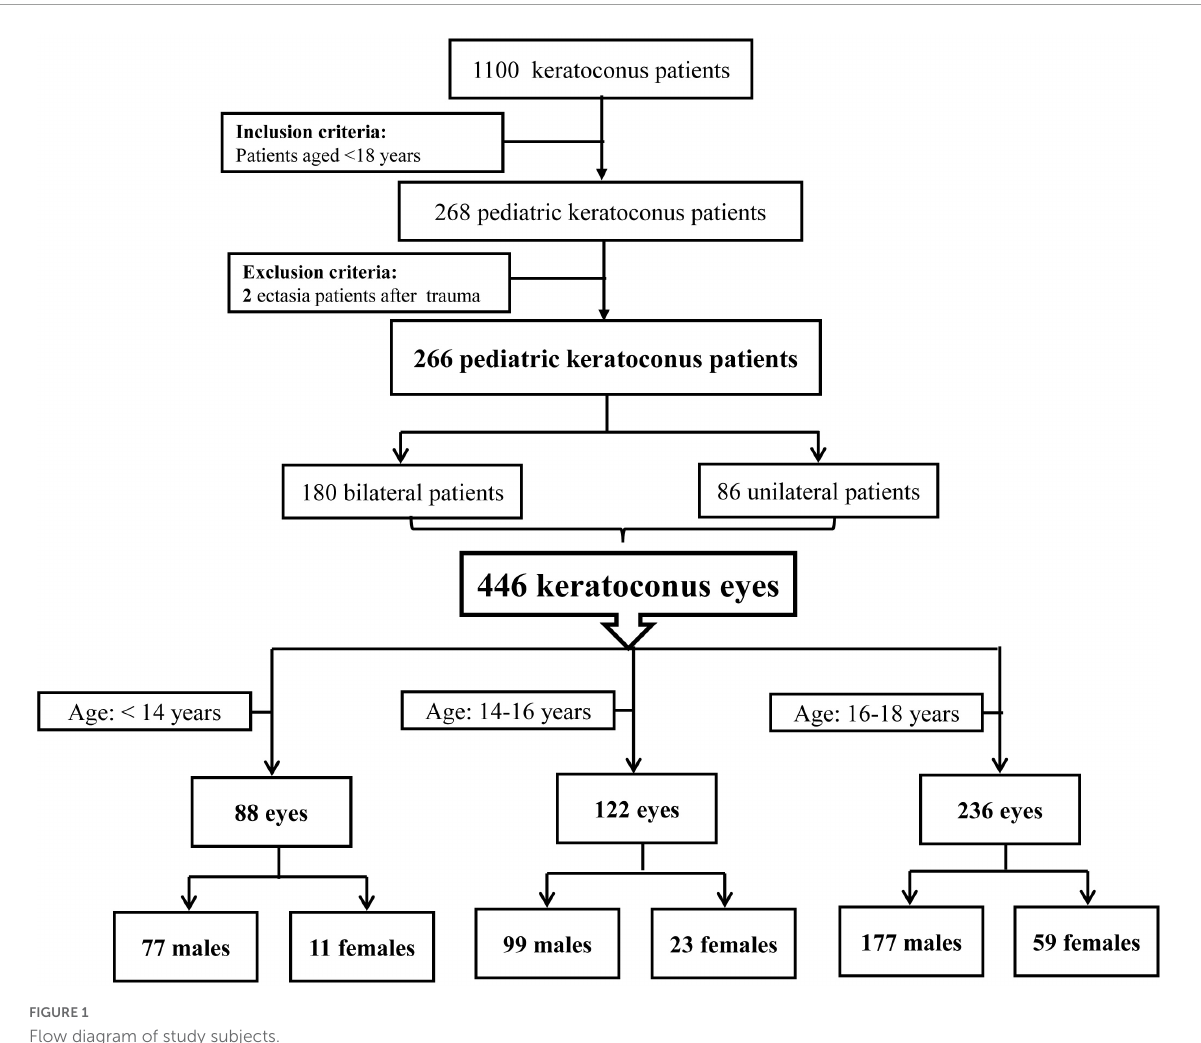
FIGURE1 Flow diagram of study